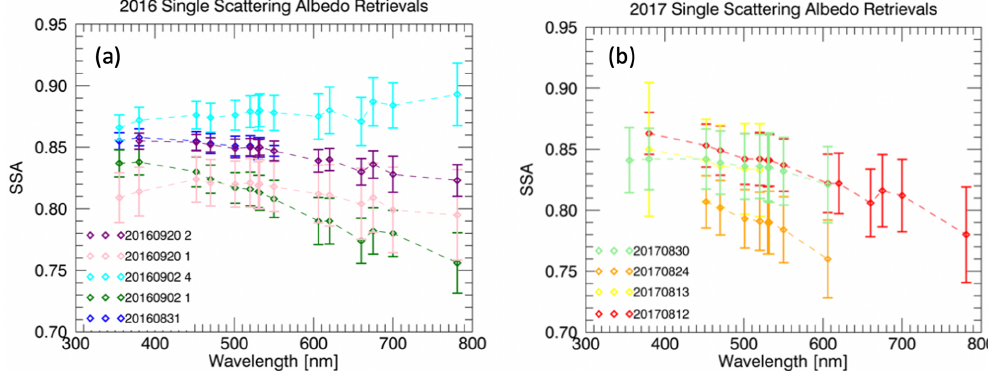
Figure E1. SSA retrievals from (a) 2016 and (b) 2017 with associated retrieval uncertainty.